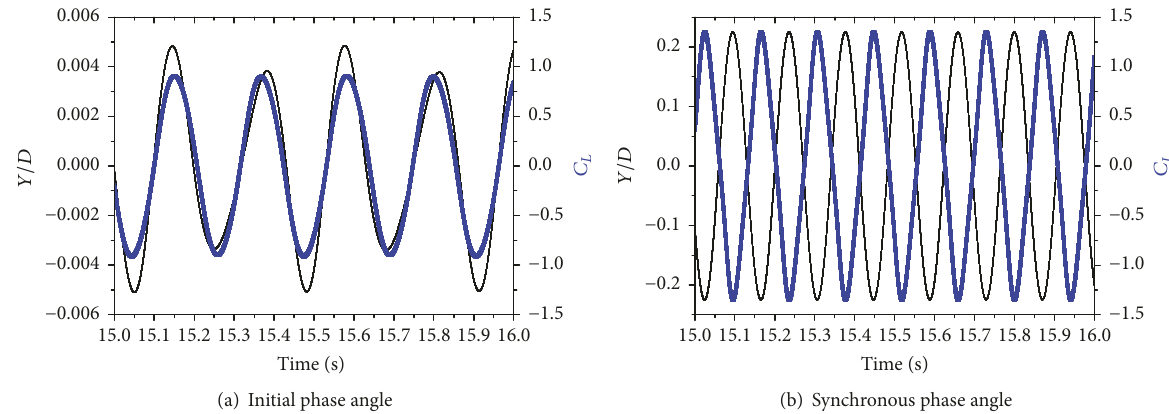
Figure 15: Results of phase angle in initial and synchronization state for 𝛼 = 45 ∘ .